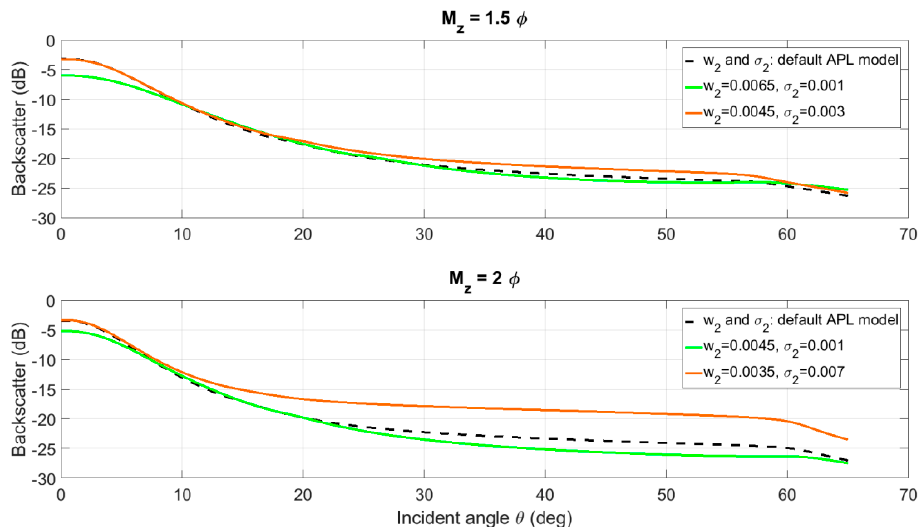
Figure 8. Examples of predicted backscatter curves of two grain size values M z = 1.5 φ ( top ) and M z = 2 φ ( bottom ) for which spectral strength w 2 and volume scattering parameter σ 2 were inverted using optimization method.